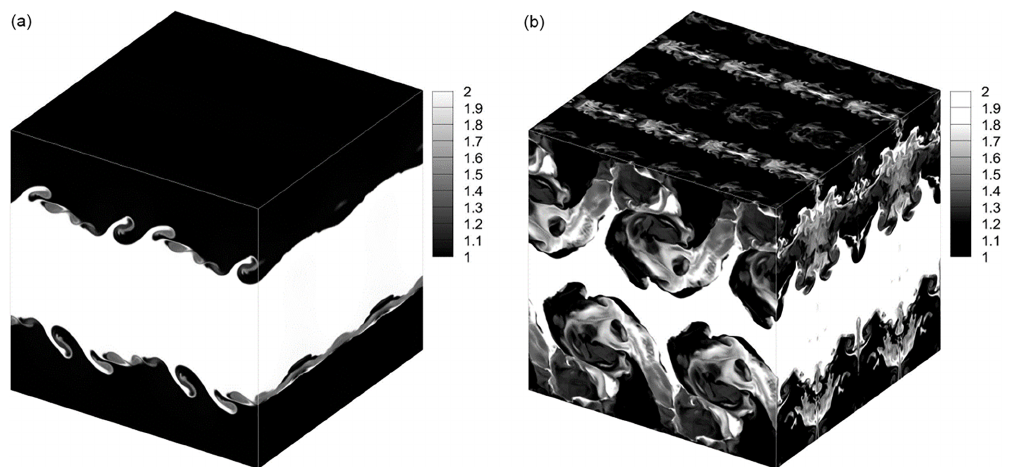
Figure 8. Time evolution of the density field for 3-D KHI turbulence with α = 0 . 25 demonstrating results at t = 1 (a) and t = 5 (b) obtained by a grid resolution of N 3 = 512 3 .